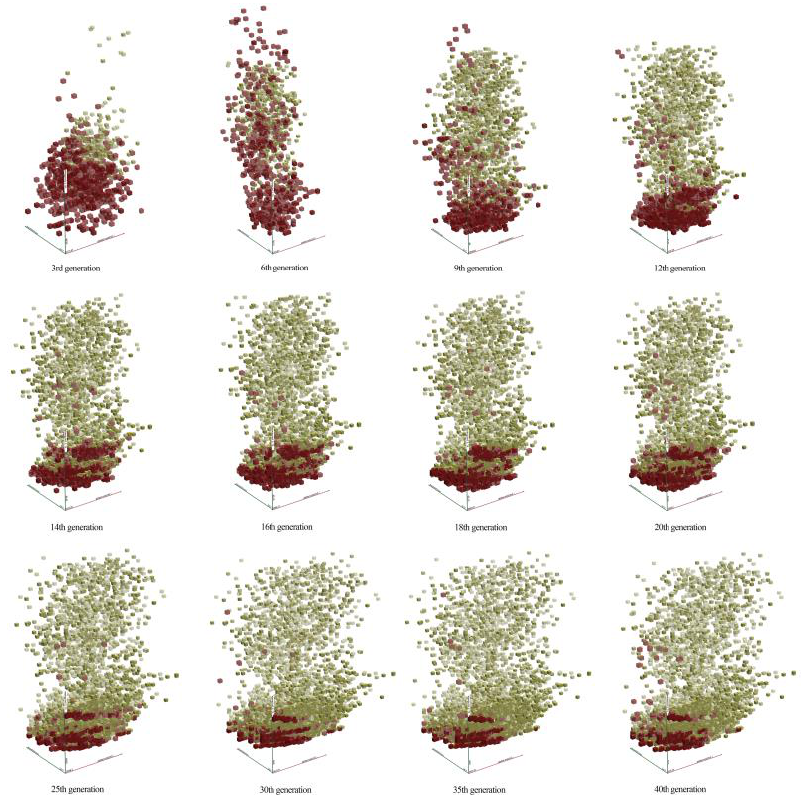
Figure 13. Multi-objective optimization iteration with Duluth as an example.